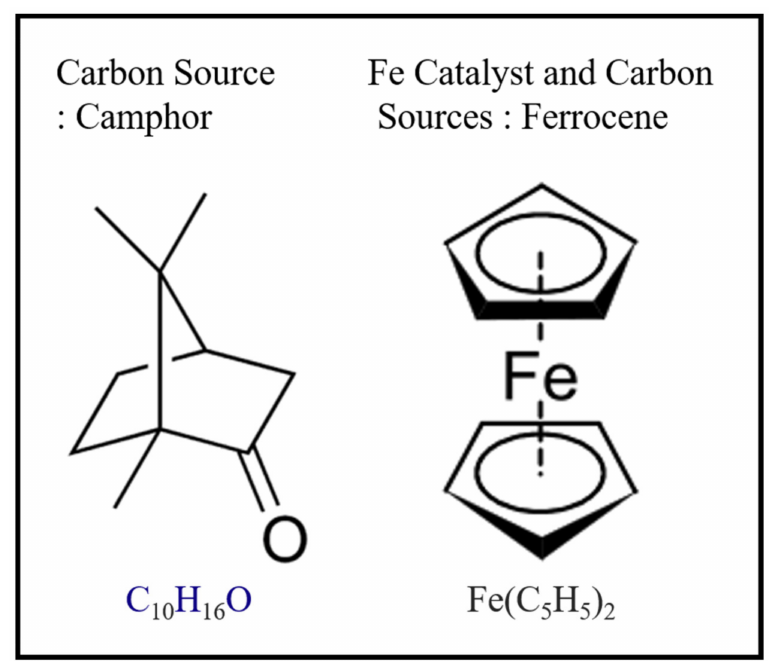
Figure 2. Molecular structures of camphor and